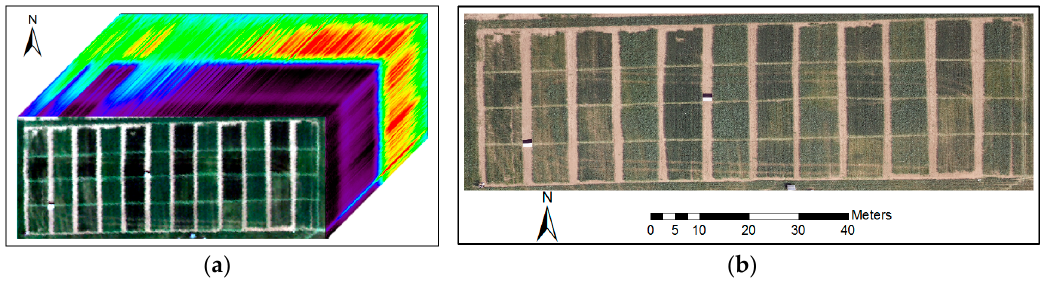
Figure 9. Spectral cube of the hyperspectral DOM ( a ) (RGB display, R: 670 nm, G: 550 nm, B: 480 nm) and DOM derived from digital RGB images ( b ).